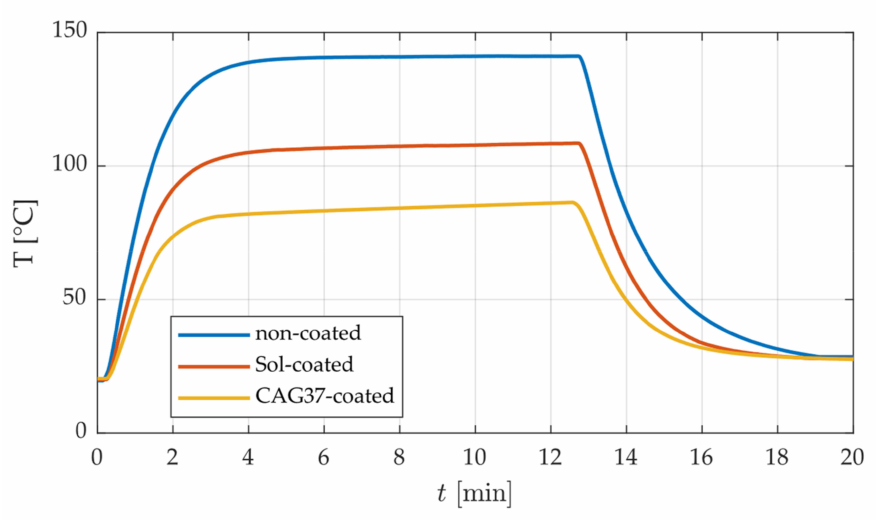
Figure 17. Heating up curves of the three tested samples; arithmetic mean values after three tests for each sample; error bars not indicated due to measurement frequency of 10